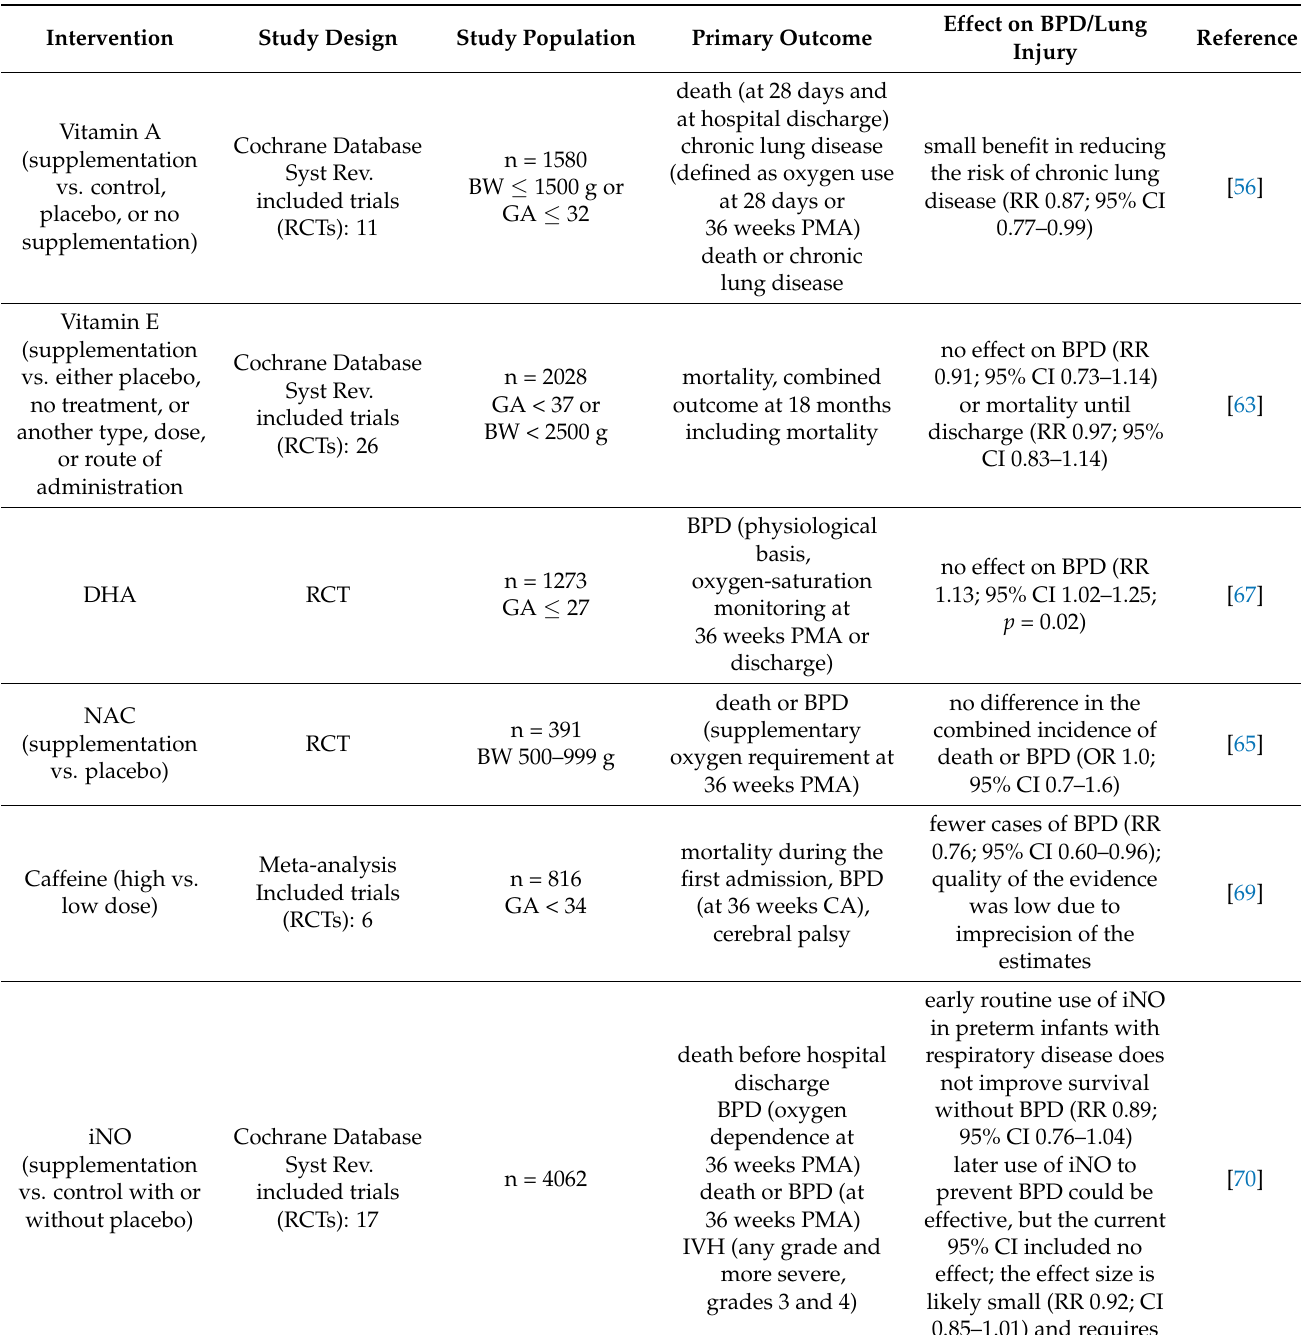
Table 1. Clinical approaches to prevent ROS-induced lung injury and